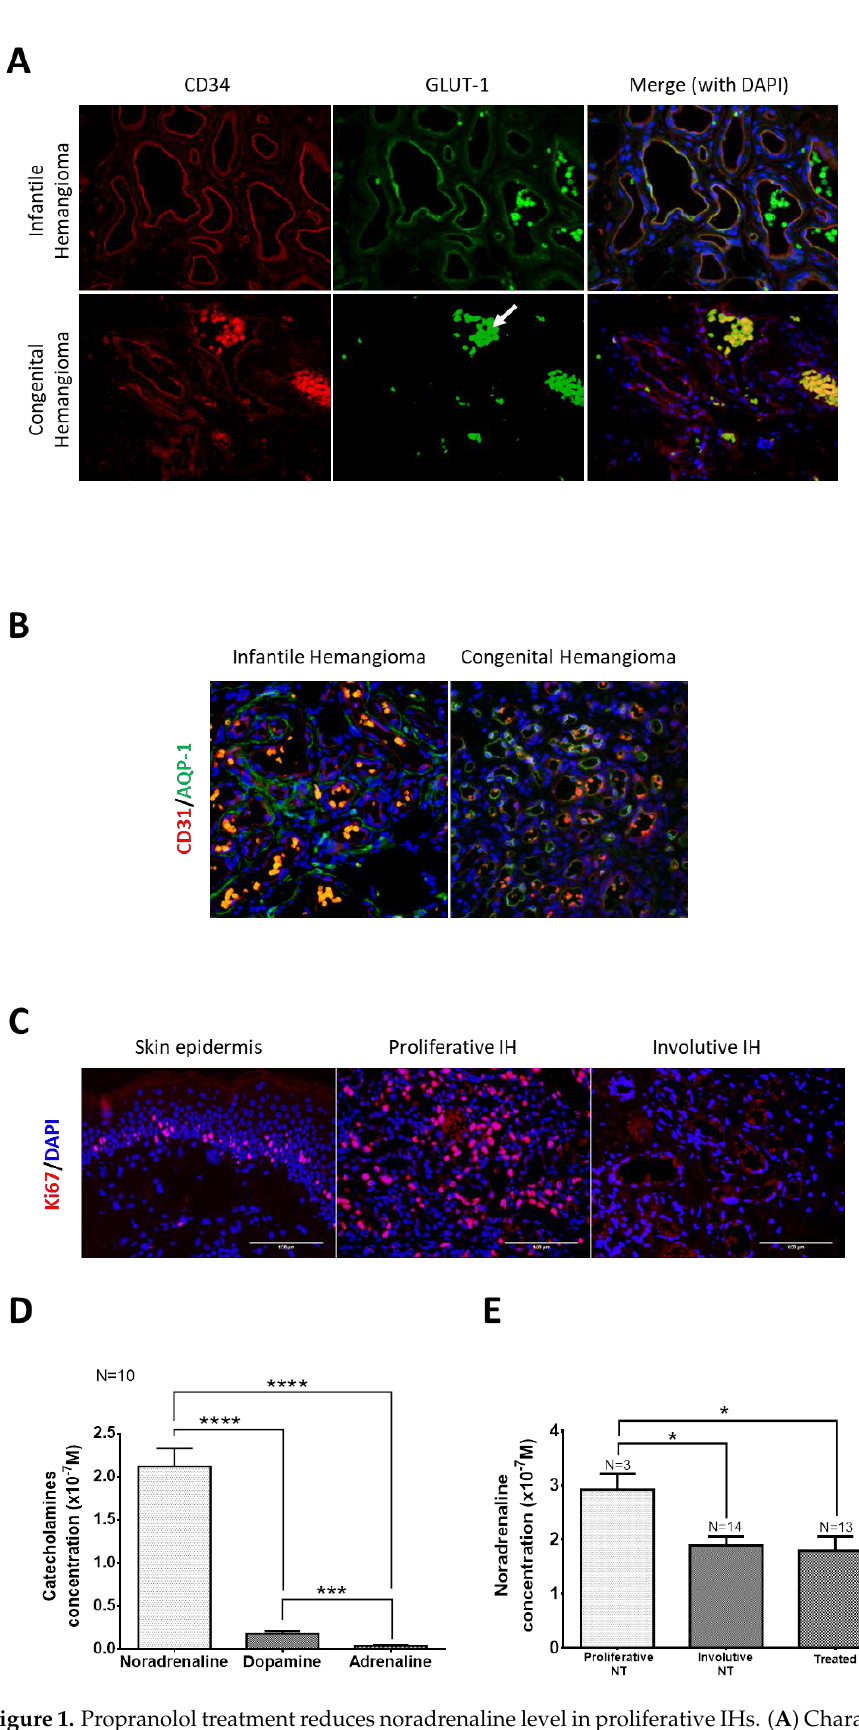
Figure 1. Propranolol treatment reduces noradrenaline level in proliferative IHs. ( A ) Characterization of IHs compared to congenital hemangiomas by GLUT-1 immunofluorescence staining. Red